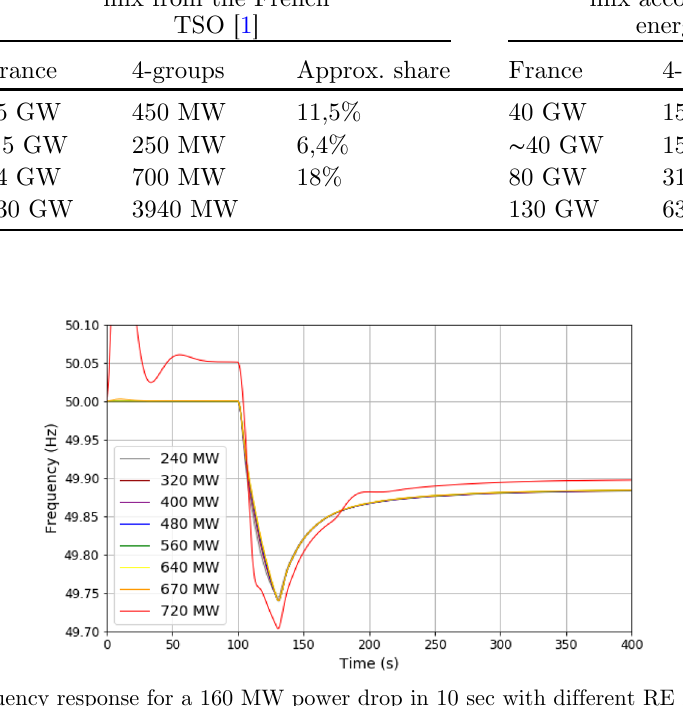
Fig. 6. Frequency response for a 160 MW power drop in 10 sec with different RE initial